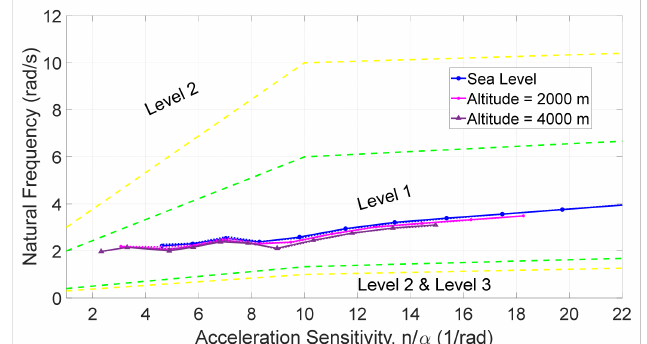
Figure 14. Undamped natural frequency versus acceleration sensitivity for Short Period oscillations; (solid lines account for the optimization using mass minimization scenario and dotted-lines are for the drag optimization in trim